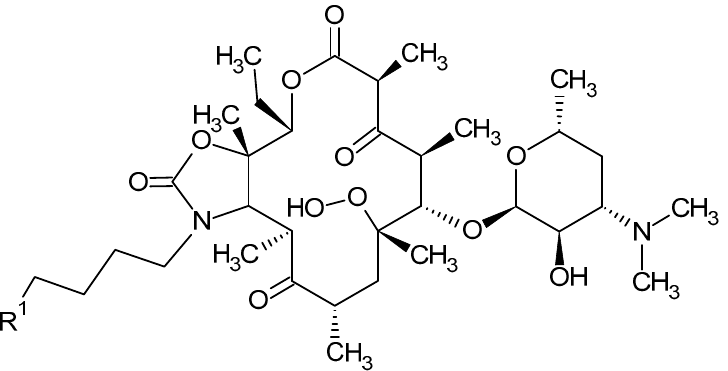
Figure 3. Telithromycin. R1—pyridylimidazole ‐ alkyl side chain.